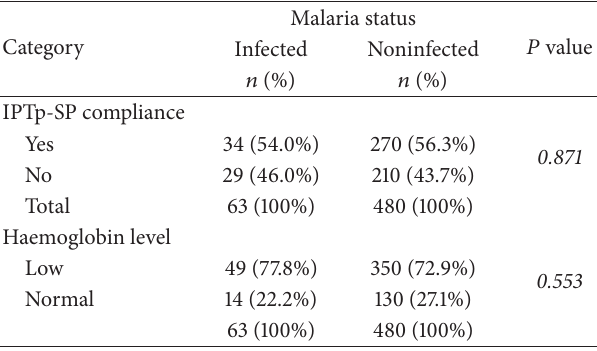
Table 1: IPTp-SP compliance and haemoglobin level against malaria in pregnant women.